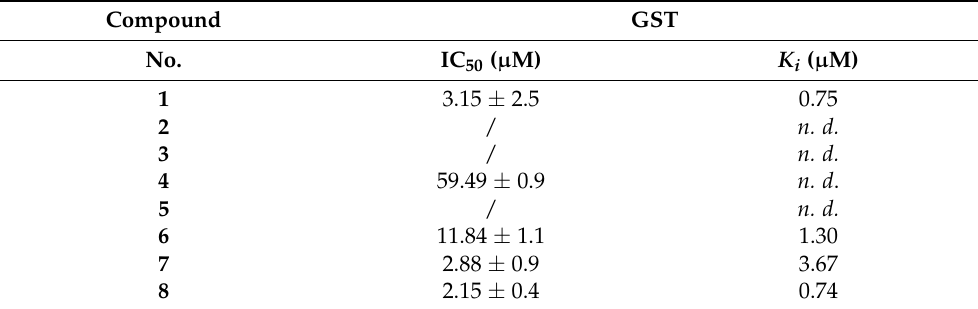
Table 3. Inhibition of glutathione S -transferase from horse liver (GST) by ruthenium compounds